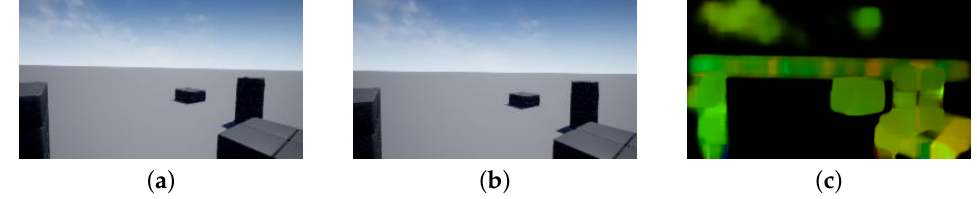
Figure 3. Optical flow map generated from inputs and outputs: ( a ) Previous frame, ( b ) Next frame, ( c ) Optical flow map.